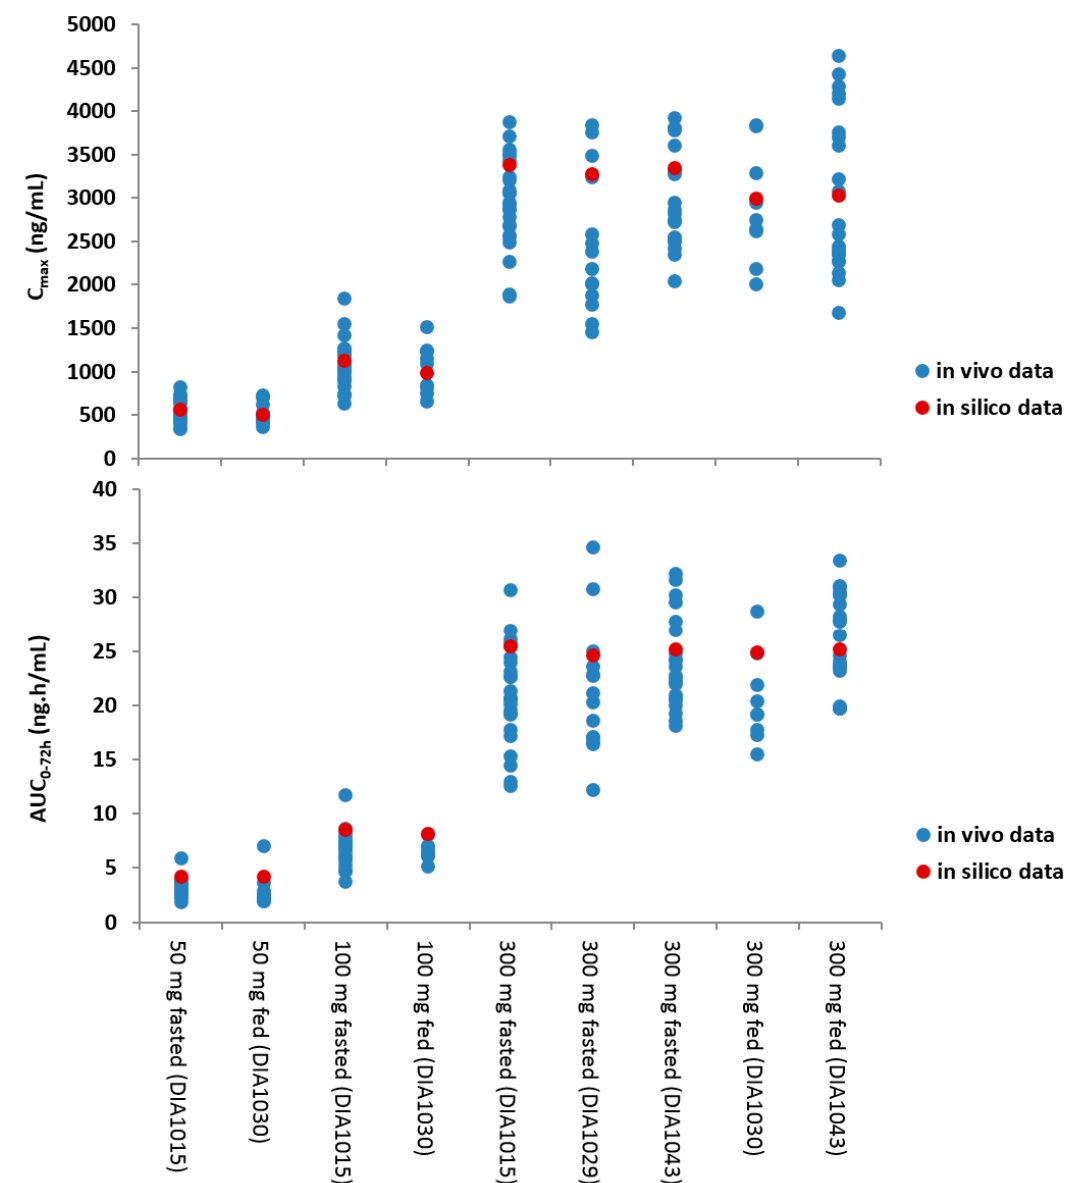
Figure 4. Visualization of the in silico versus the in vivo pharmacokinetics (PK) parameters at di ff erent dose levels and in fasted and fed conditions. The blue dots represent the in vivo data, the red dot represents the in silico mean prediction.